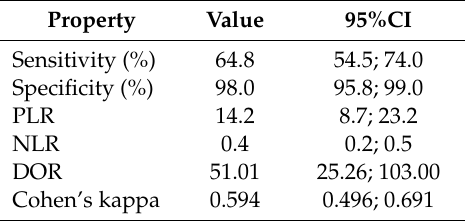
Table 2. Summary of the properties of point-of-care rapid diagnostic testing for the COVID-19.